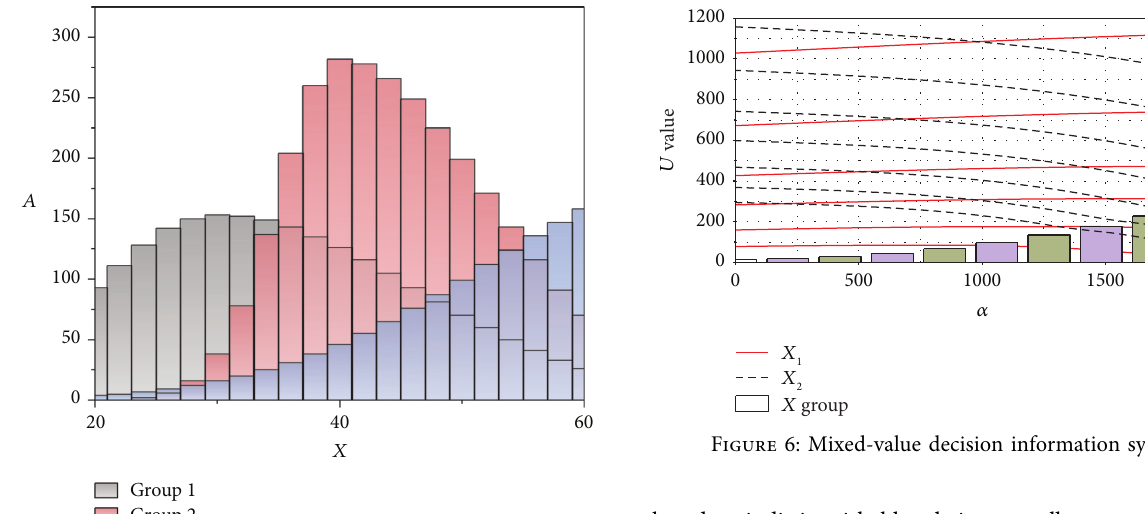
Figure 6: Mixed-value decision information system.